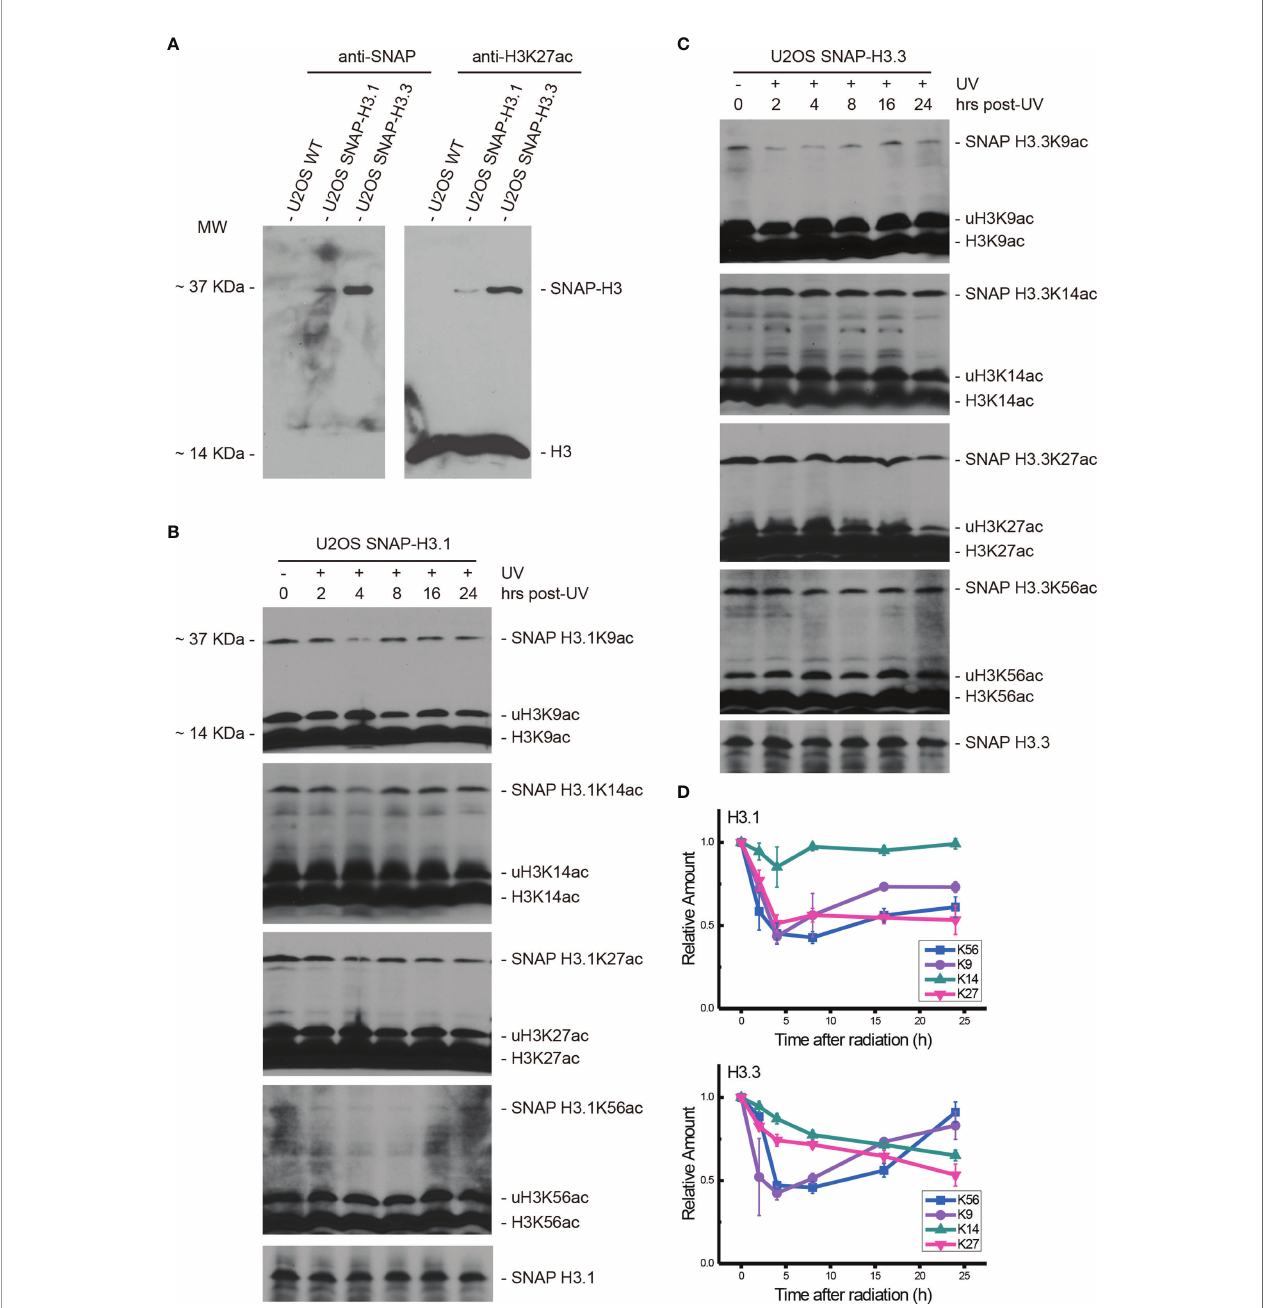
FIGURE 1 | Both H3.1K56ac and H3.3K56ac were transiently suppressed by UV radiation and restored following DNA damage repair. (A) SNAP-tagged histone H3.1 and H3.3 were investigated in wild-type U2OS cells and H3.1-SNAP U2OS and H3.3-SNAP U2OS cells by an anti-SNAP antibody and anti-H3K27ac antibody. Bands at approximately 37 kDa indicate SNAP-tagged histone H3 or SNAP-tagged lysine 27 acetylated histone H3, respectively. (B) H3.1-SNAP U2OS cells were treated with 20 J/m 2 UV radiation. The insoluble nuclear protein samples were collected at 0 h, 2 h, 4 h, 8 h, 16 h, and 24 h after radiation treatment. The acetylation levels of H3K9, H3K14, H3K27, and H3K56 were examined. SNAP-tagged histone H3 was used as an internal reference. (C) H3.3-SNAP U2OS cells were treated with 20 J/m 2 UV radiation. The insoluble nuclear protein samples were collected at different time points after radiation treatment. The acetylation levels of H3K9, H3K14, H3K27, and H3K56 were investigated, and SNAP-tagged histone H3 was used as an internal reference. (D) Time-course alteration of acetylated K9, K14, K27, and K56 of H3.1 or H3.3 after 20 J/m 2 UV radiation. The data are normalized immunoblotting results by ImageJ analysis from three separate